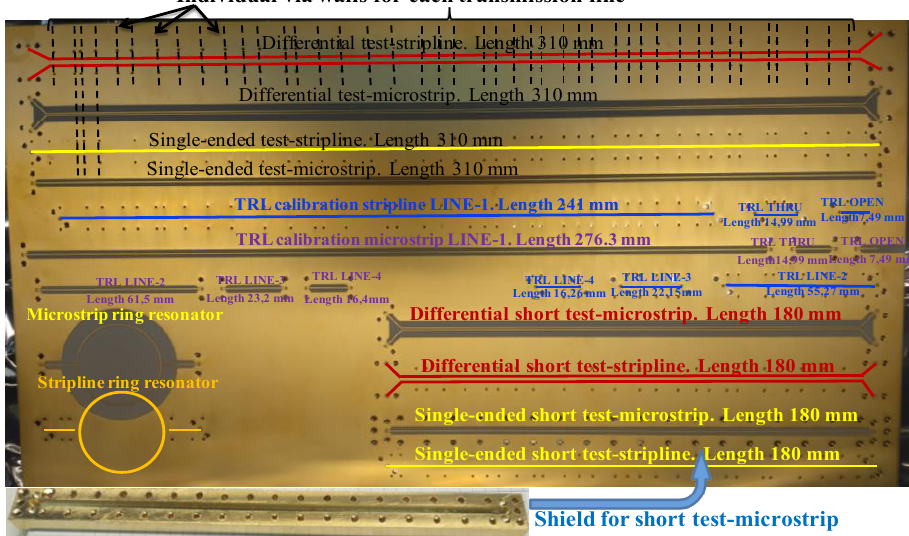
Fig. 4. General board